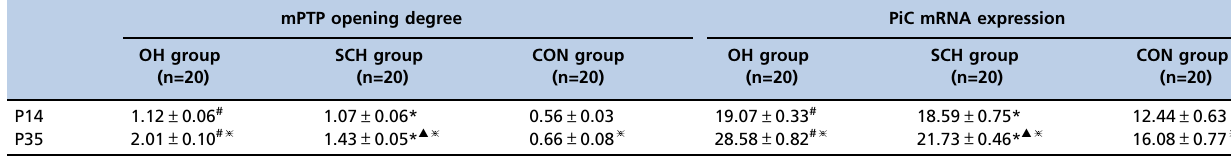
Table 2 - The differences in the degree of mPTP opening and PiC mRNA expression among the groups ( (cid:1) x ± s). mPTP opening degree PiC mRNA expression